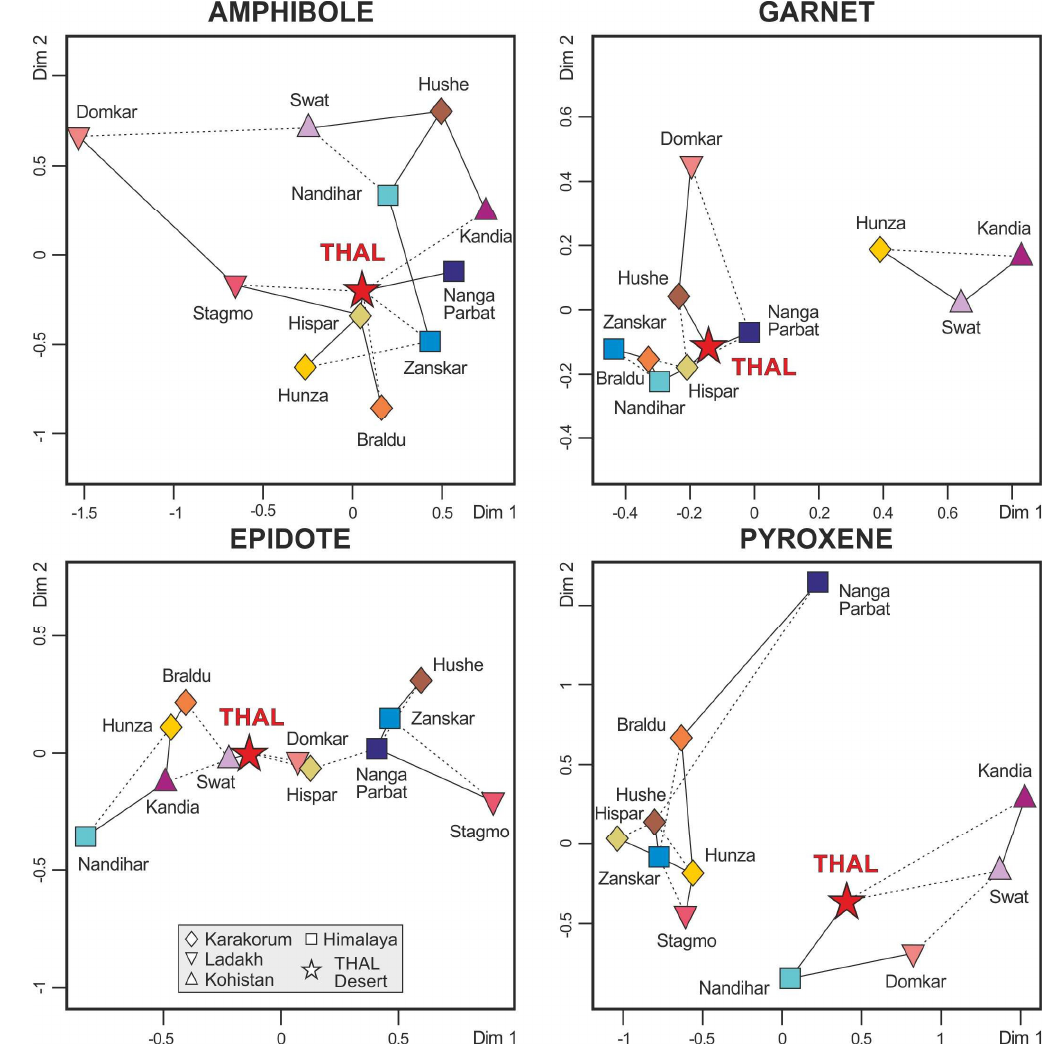
Figure 7. Multidimensional scaling maps based on the chemical signatures of the four studied mineral groups in river sands of northern Pakistan and in the Thal Desert (Supplementary Tables S7–S10). The four Thal dune samples are considered as subsamples of the same unitary population. Solid and dashed lines link closest and second-closest neighbors, respectively. The higher “stress” values (poorer fit) obtained for the amphibole (11.2%) and pyroxene maps (8.9%) than for the garnet (2.4%) and epidote maps (0.8%) largely reflect the higher number of varieties identified for amphibole (32) and pyroxene (39) than for epidote and garnet (six each). The four maps—plotted using the provenance package of Vermeesch et al. [129]—di ff er because di ff erent minerals are contained in markedly di ff erent proportions (fertilities) in di ff erent source-rock domains. Similarities among mineralogical spectra indicate the Kohistan arc as the main supplier of epidote and pyroxene, whereas amphibole and garnet were largely derived also from the Karakorum (Southern Karakorum gneiss domes drained by the Hispar River) and Himalaya (Nanga Parbat massif). The shape and color of sample symbols are same with those of Figures